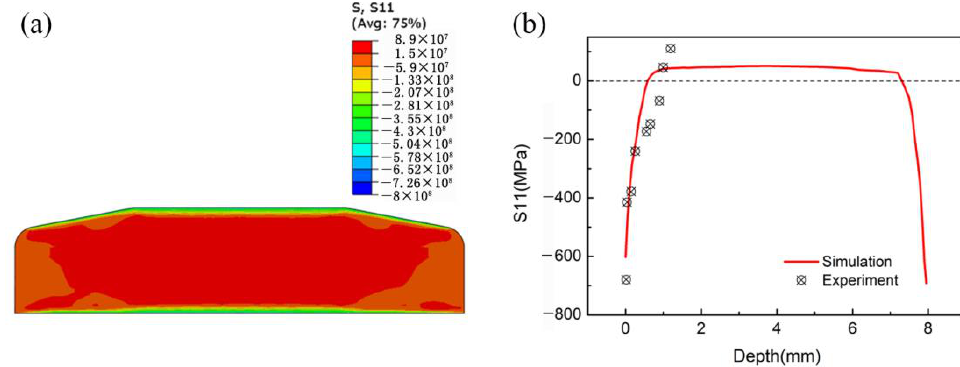
Figure 6. ( a ) Cross-sectional residual stress distribution of the LSP-treated specimen; ( b ) comparison of simulated and measured residual stresses along the depth of the specimen.